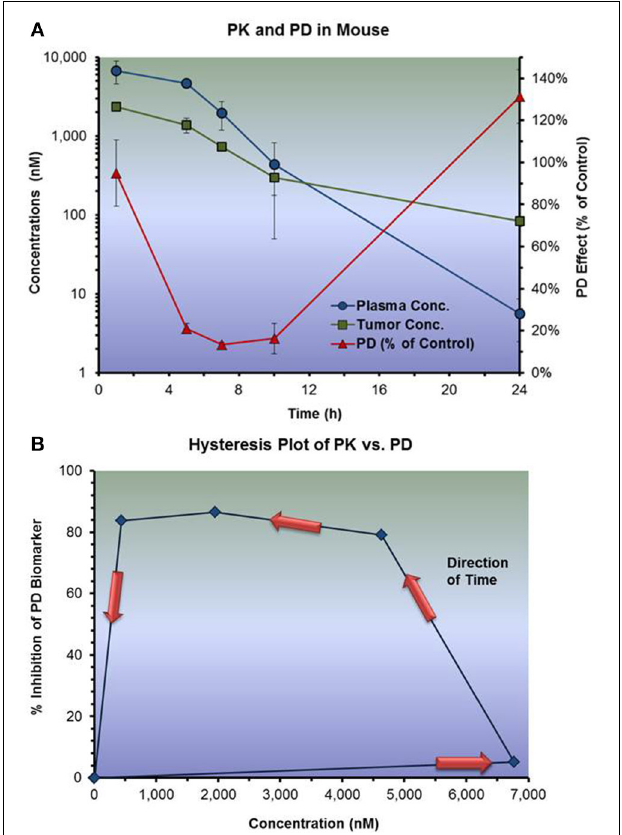
FIGURE 8 | Effect vs. plasma concentration of a drug candidate following a single oral dose to tumor bearing mice. (A) Shows the PK and PD response both plotted against time. (B) Shows the PK plotted directly against PD. Delayed pharmacodynamic response resulted in a hysteris plot. An indirect response model (inhibition of input function) was subsequently developed to describe and predict PD response inhibition based upon various dosing